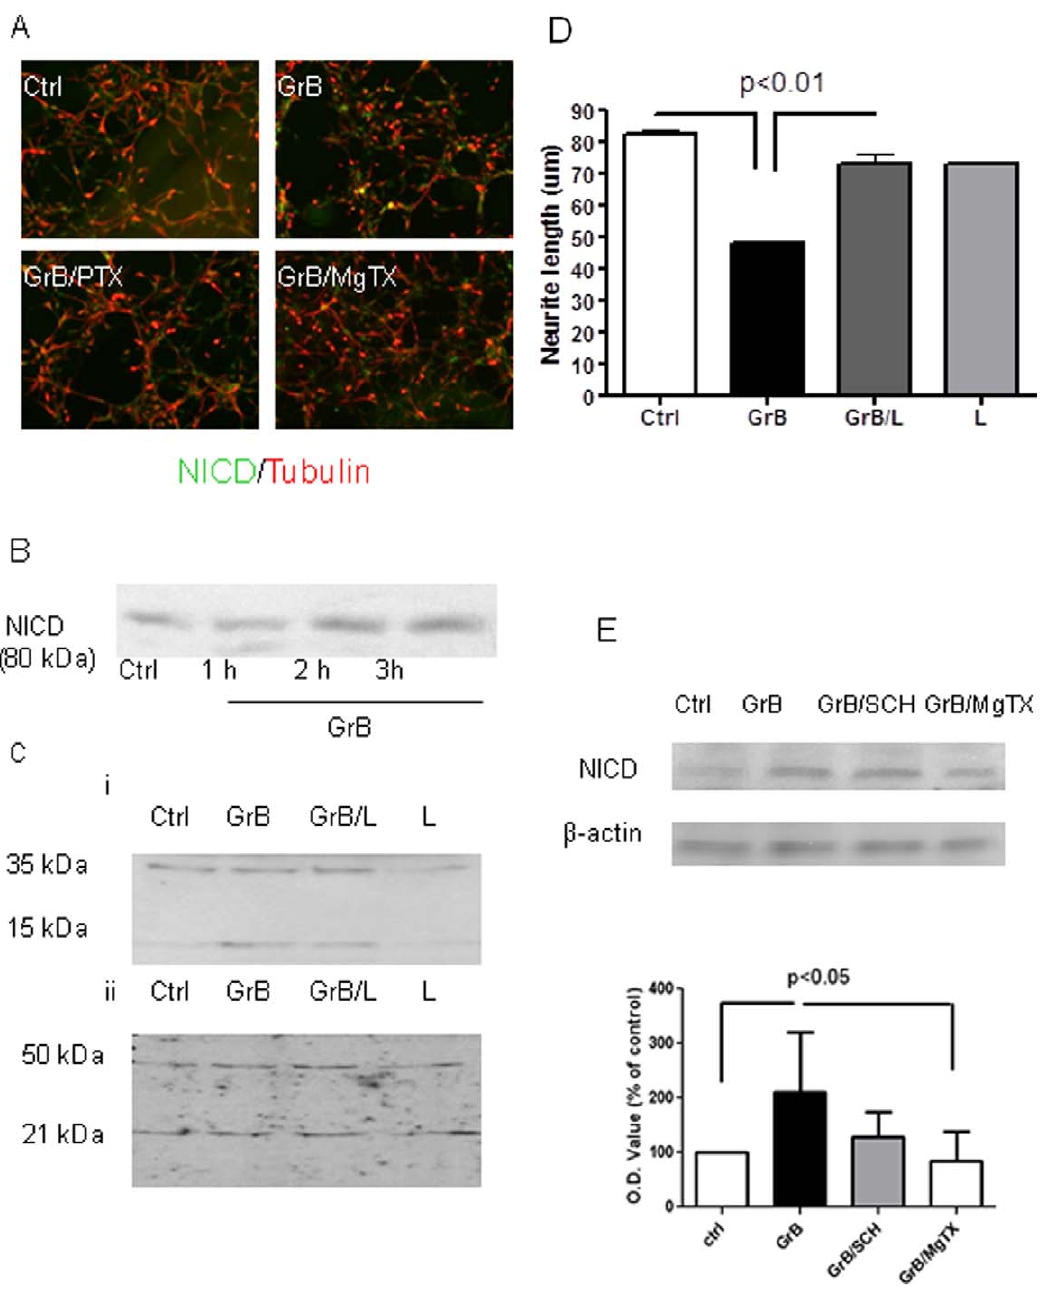
Figure 4. GrB activates Notch-1 receptor. (A) Human fetal neuronal cultures were treated with GrB (4 nM) with or without PTX (100 ng/ml) and MgTX (10 nM) for 18 hr. Cells were then fixed and immunostained for NICD and beta-III tubulin. Representative photomicrographs from three independent experiments with similar results are shown. GrB treatment for 18 hr increased intracellular Notch-1 activation in neurons, while pretreatment with PTX (100 ng/ml) or MgTX (10 nM) both significantly attenuated the effect. (B) Western-blot analysis showed that GrB increased Notch-1 activation in a time-dependent manner and NICD production reached peak within 3 hr. Representative blots from three independent experiments with similar results were shown. (C) Primary cultured human neurons were treated with GrB (4 nM) for 24 hr with the supernantants (sups) and cell lysates collected separately. Cell lysates (i) and concentrated sups (ii) were then used for Western-blot analysis. By using NICD antibody, an extra15 kDa band was found in the GrB-treated cell lysates which was attenuated by pretreatment with Notch-1 inhibitor ‘‘L’’ (10 m M). No significant changes were noted in the bands from the sups when using an antibody specific to C-terminal extracellular Notch-1 fragments. Representative blots from three independent experiments with similar results are shown. (D) Human fetal neuronal cultures were treated with GrB (4 nM) with or without ‘‘L’’ (10 m M) pretreatment. After 24 hr, neurons were immunostained for beta-III-tubulin and average neurite lengths were measured. Results represent average 6 SEM from three independent experiments. (E) Human fetal neuronal cultures were pretreated with SCH (50 nM) and MgTX (10 nM) 30 min prior to GrB (4 nM) incubation. Cell lysates were collected 3 hr later for Western blot analysis using an antibody specific to NICD. Results represent average 6 SEM from five independent experiments. A representative blot is